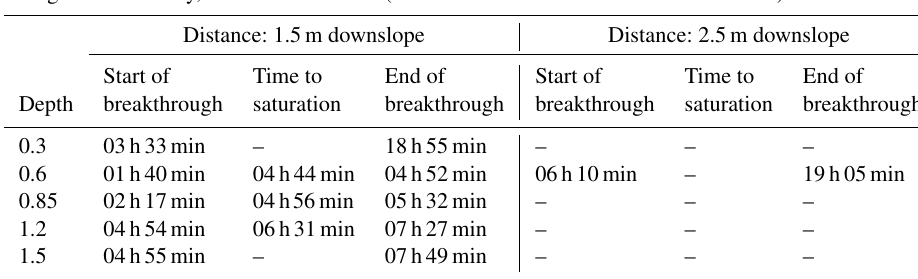
Table 2. Characteristic breakthrough times at different depths for the first irrigation. Irrigation I: 27 May, 15:05–19:54CEST (duration: 4h49min – 670l ≈ 61.8mmh − 1 ) Distance: 1.5m downslope